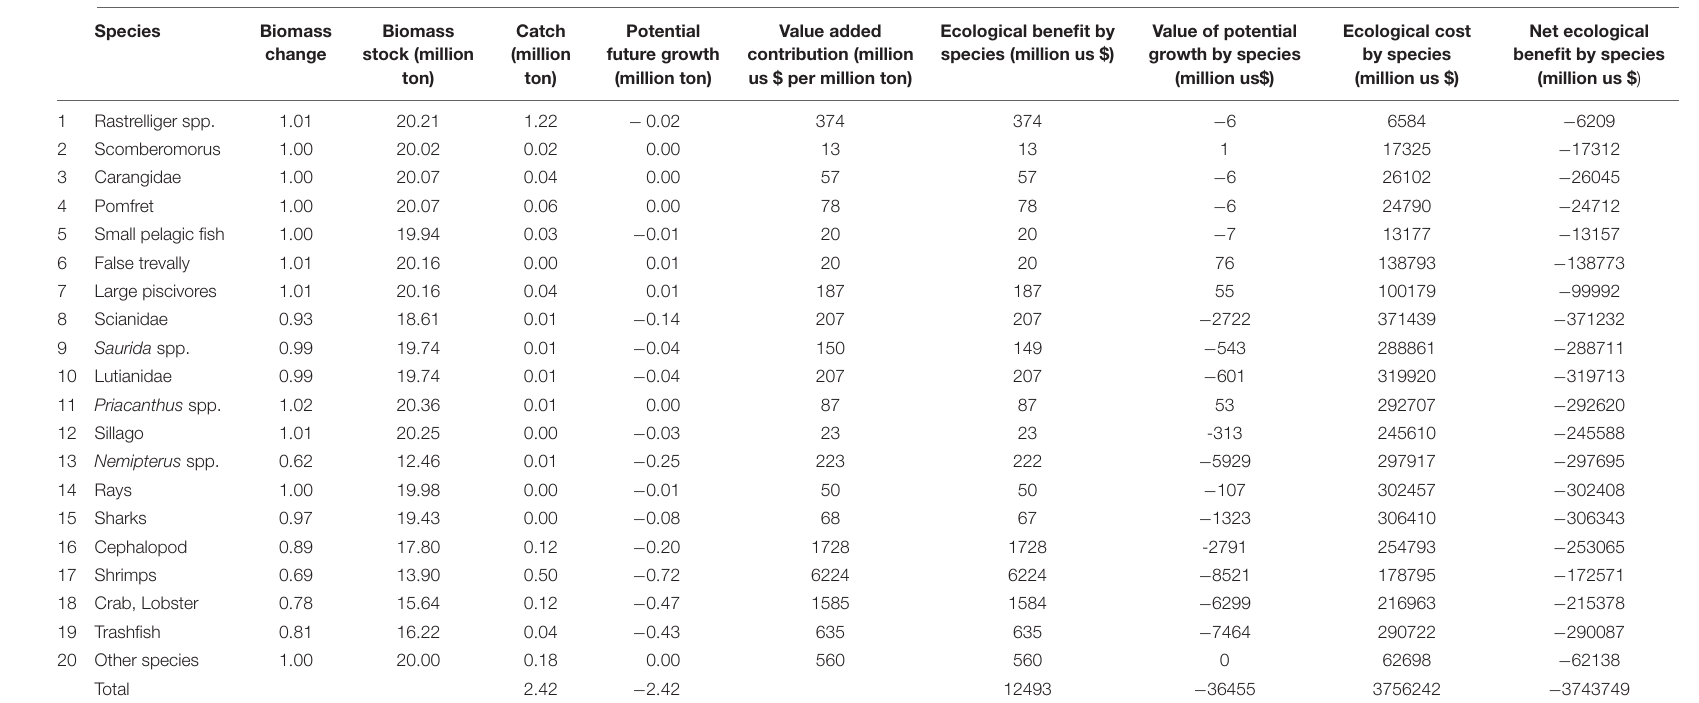
TABLE 5 | Results on ecological performance in